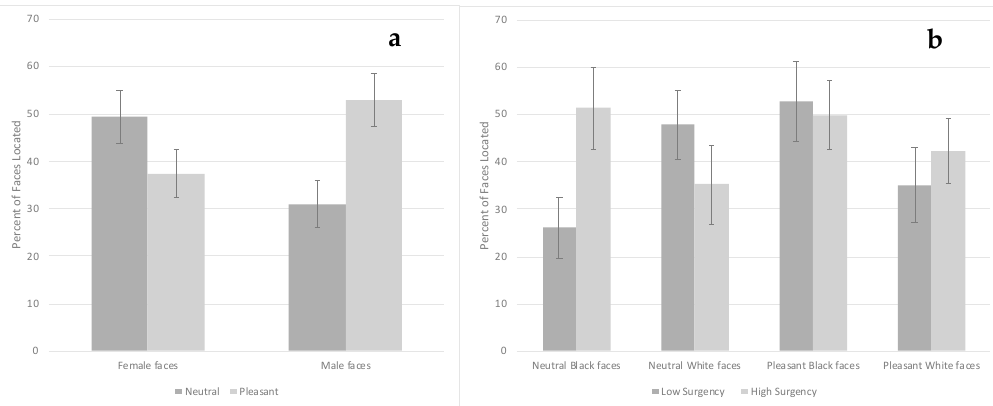
Figure 10. The percent of faces infants located based on face gender and expression (( a )—left chart) and their surgency and face race and expression (( b )—right chart). Bars represent standard error. There was also a Condition × Face Race × Surgency interaction, χ 2 = 6.43, p = 0.011.